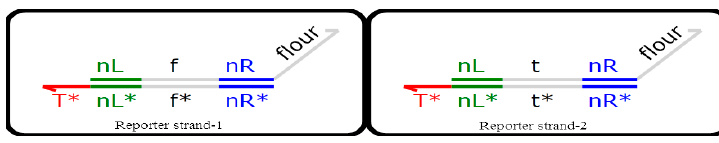
Figure 9. Reporter gate with a domain label.